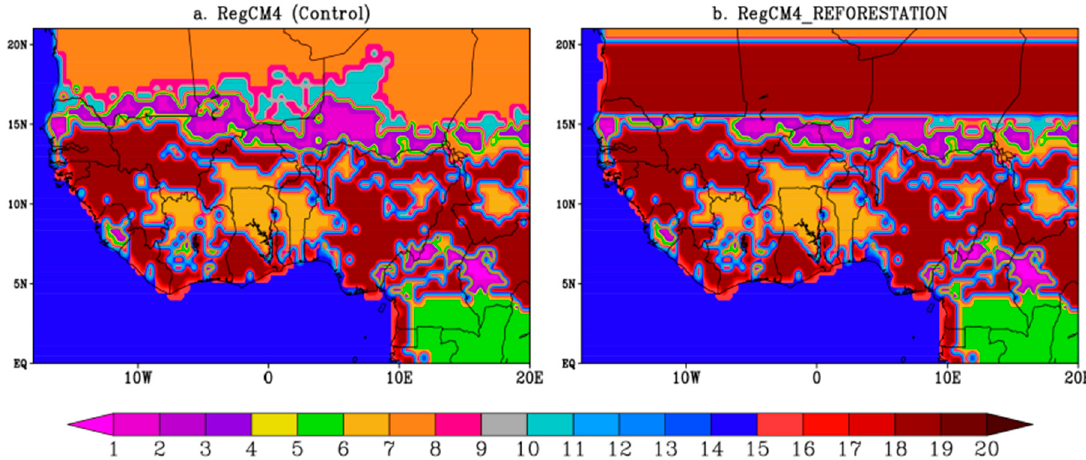
Figure 2. Distribution of land cover types in the study domain: ( a ) the standard version of RegCM4 model and ( b ) the reforested version RegCM4_REFORESTATION. The reforested zone (between 15° N–20° N). Table 1. Land cover types/vegetation classes used in this study. NB: the values below indicate the type of land cover used in this study which can be found in the legend of Figure 2.